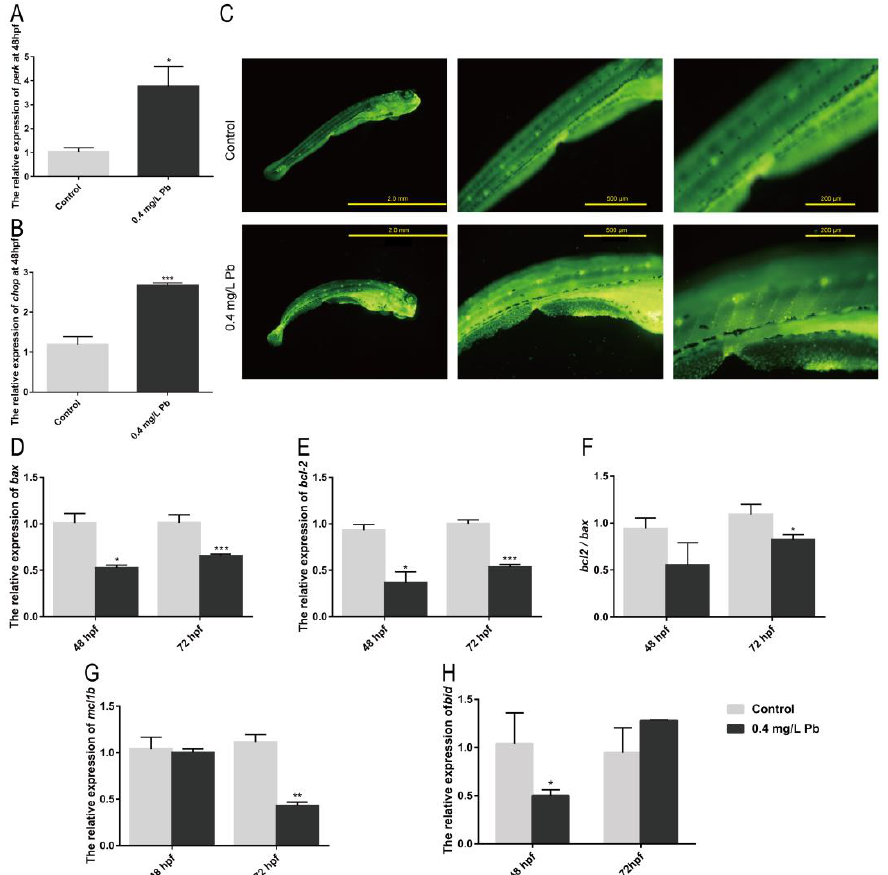
Figure 4. mRNA expression of ER stress and apoptosis-related genes in zebrafish. mRNA expression of ER stress- related genes in zebrafish embryos at 48 hpf using ef1α as reference: ( A ) perk , ( B ) chop . ( C ) AO staining; mRNA expression of apoptosis-related genes in zebrafish embryos at 48 and 72 hpf; ( D ) bax ; ( E ) bcl-2 ; ( F ) bcl-2/bax ratio; ( G ) mcl1b ; ( H ) bid . (* p < 0.05, ** p < 0.01, *** p < 0.001, n = 50.)